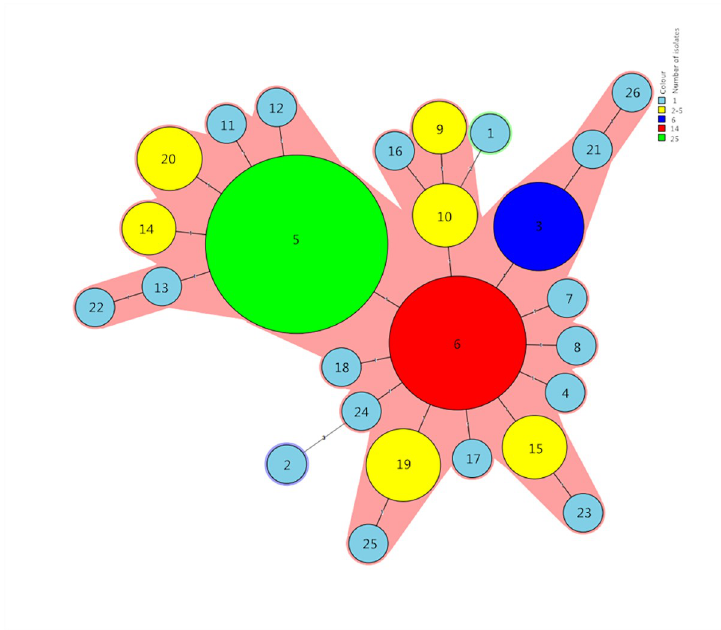
Fig 4. Genetic relationship of 79 S . Enteritidis isolates from Guizhou province based on MLVA. The minimum spanning tree (MST) was generated based on 26 MLVA types. Each circle and the number within the circle represent a different MLVA type. The size of the circle is proportional to the amount of the isolates, and the color within the circles represents the different number of isolates. The number outside of the circles indicates how many VNTR loci are different in the MLVA types of connected circles. The shadow zone means these MTs belonging to the same clonal.